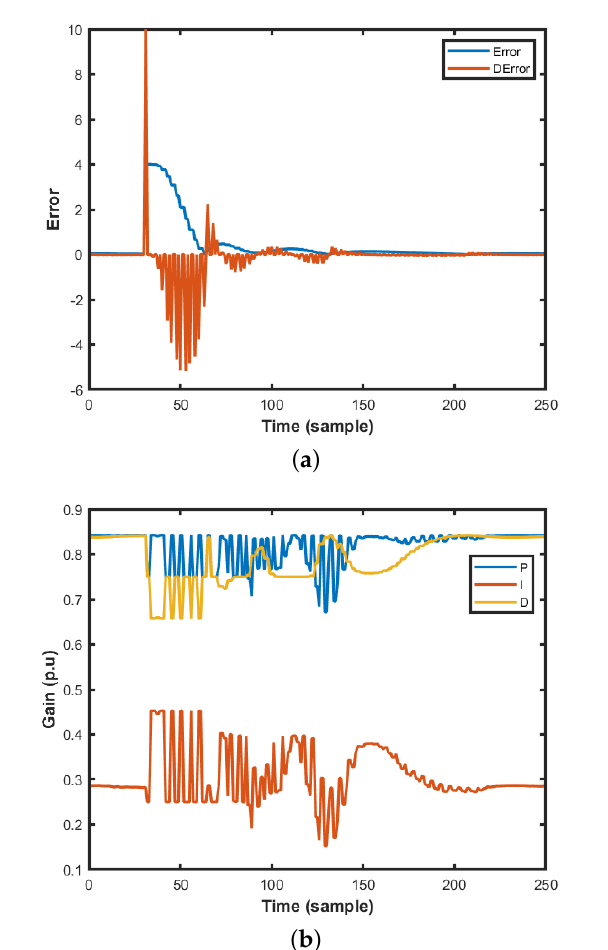
Figure 11. ( a ) Measured errors; and ( b ) Fuzzy PID